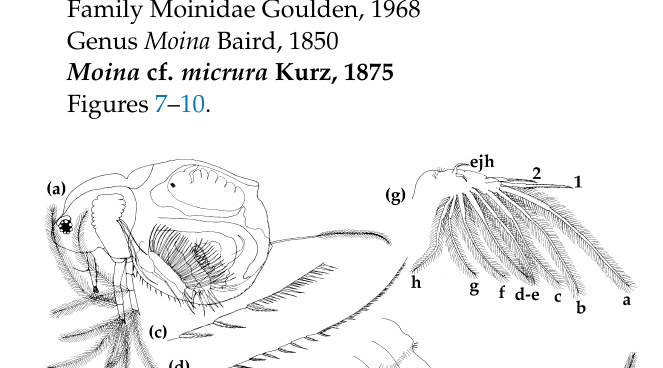
Figure 9. Moina cf. micrura , an ephippial female from Masfoot Dam 1, United Arab Emirates: ( a ) antenna II; ( b ) ephippium; ( c ) ornamentation of ephippium with higher magnification. Scale bars 0.1 mm for (b) , 0.05 mm for ( a , c ).